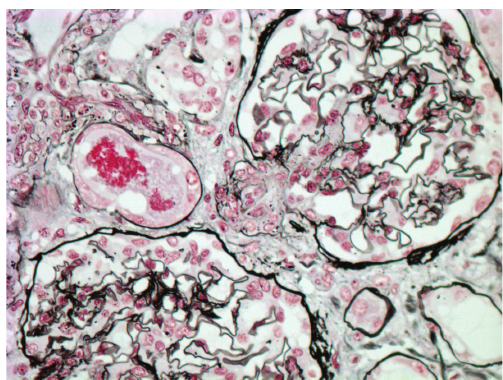
Figure 4: Prominent juxtaglomerular apparatus containing sparse silver positive renin granules in a patient with scleroderma renal crisis (Methenamine silver stain; original magnification x400).